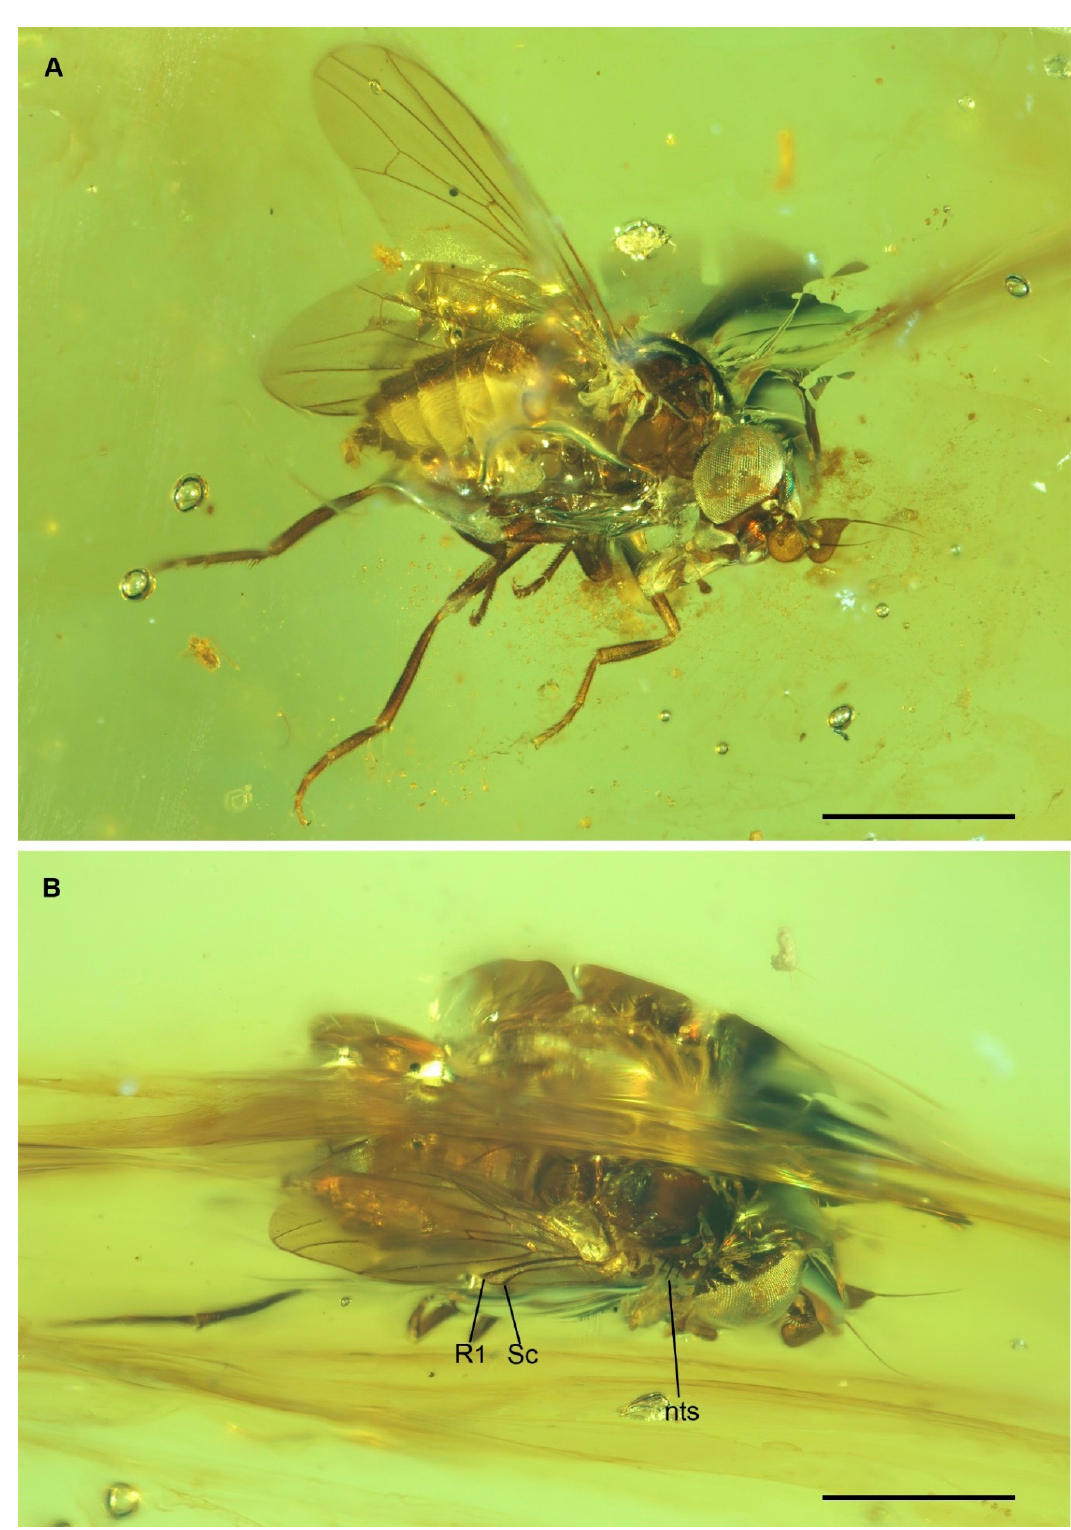
Figure 1. Lebambromyia sacculifera sp. nov., holotype, BA02-14122, habitus. ( A ) lateral view; ( B ) dorsal view. Abbreviations: Sc, Subcosta; R1, Radius; nts, notopleural setae. Scale bar: 1 mm.